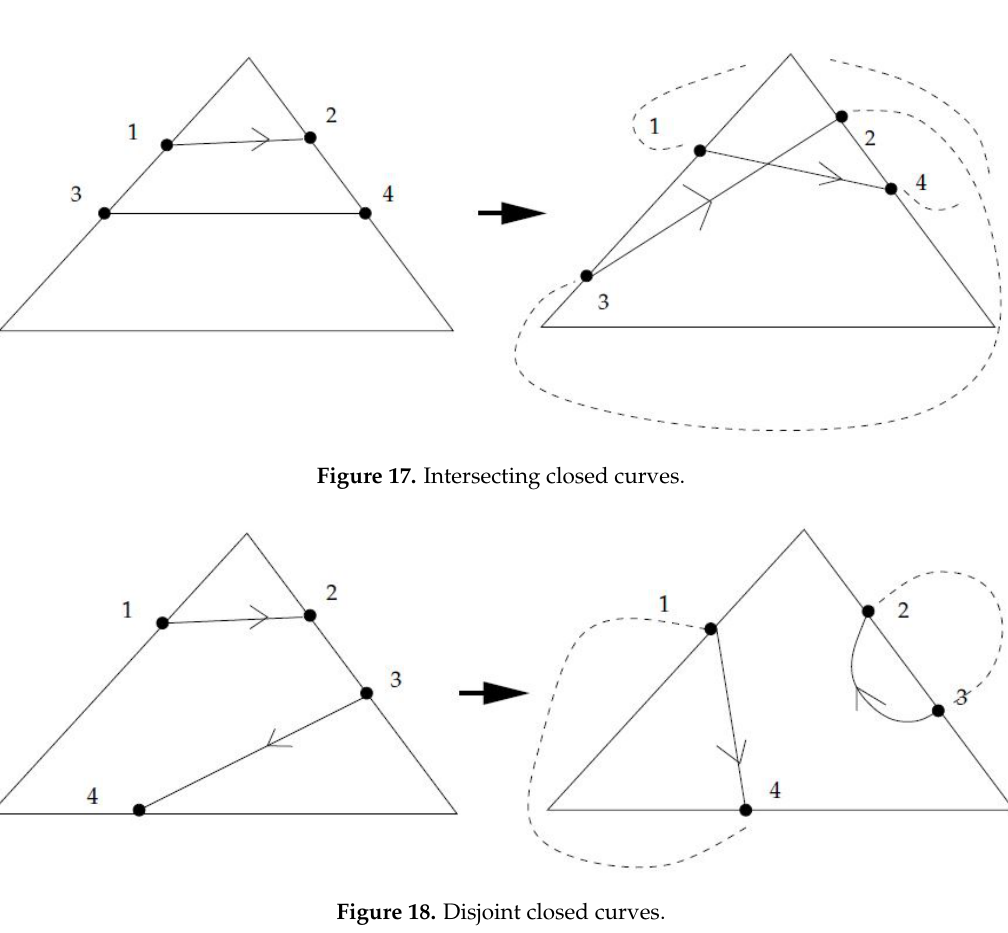
Figure 18. Disjoint closed